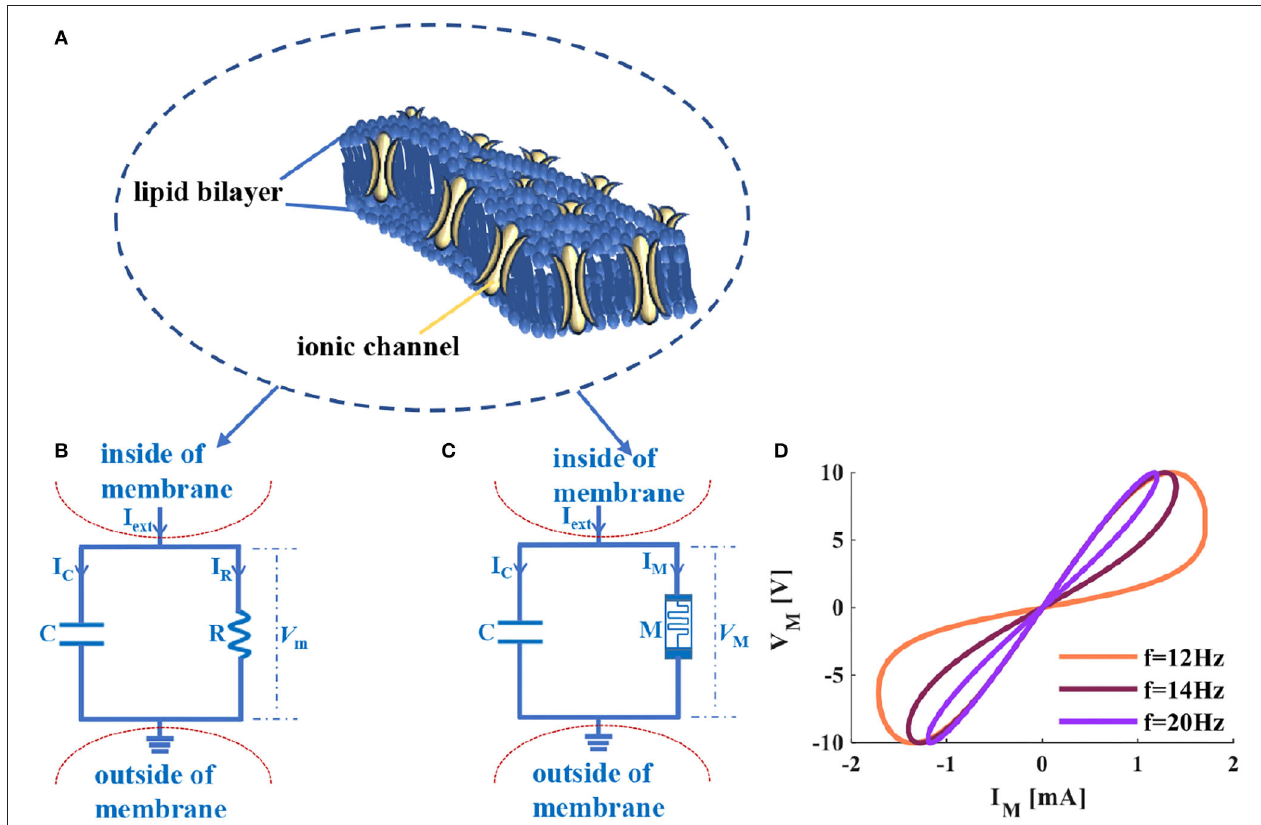
FIGURE 1 | The cellular membrane of a neuron and its circuit models, (A) the diagram of the voltage-controlled ionic channel cell membrane, (B) the RC circuit of the neuron membrane, (C) the MC circuit of the neuron membrane, (D) the voltage-current relationship of a